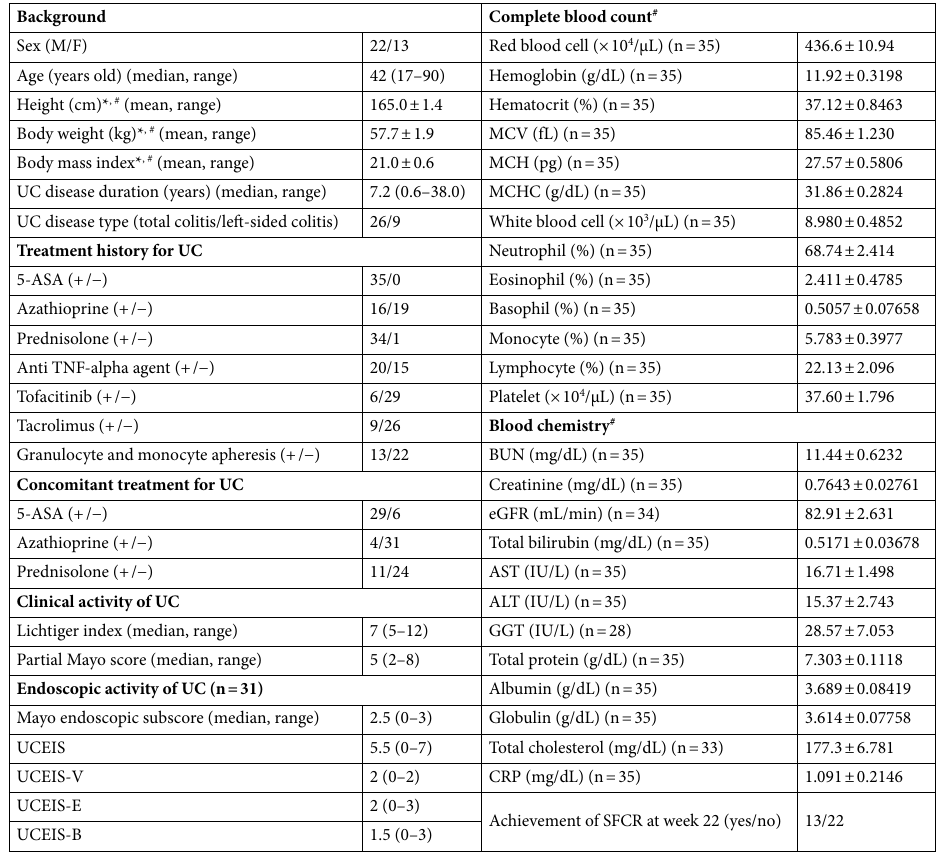
Table 3. Clinical demographics of Cohort 2 (35 patients). *Height and body mass index were not measured in three subjects. # The results of blood tests are described as the mean ±